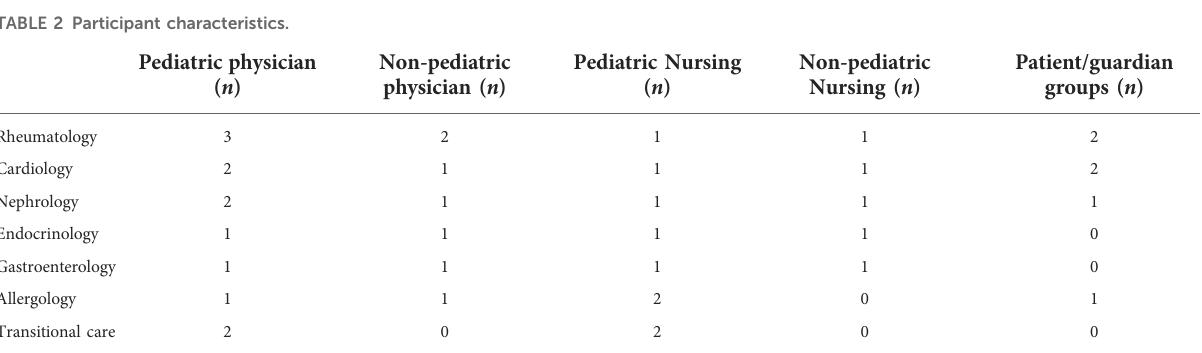
TABLE 2 Participant